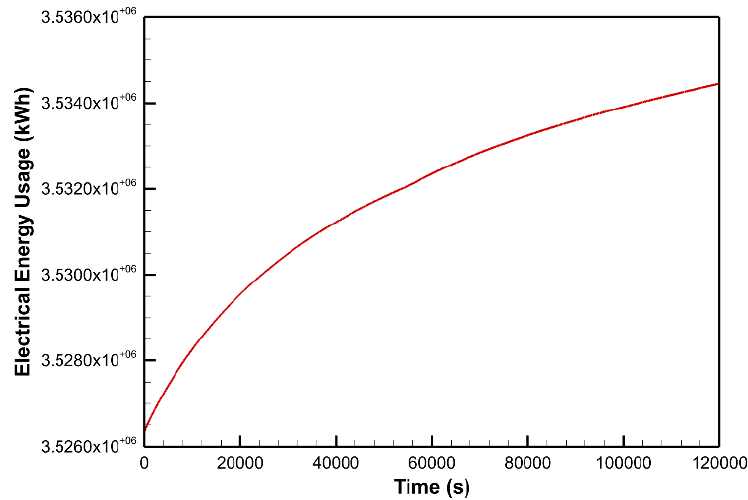
Figure 4. Transient history of electrical energy usage profile versus time, at 600 V and 60 Hz power consumed by the heating elements in the furnace.